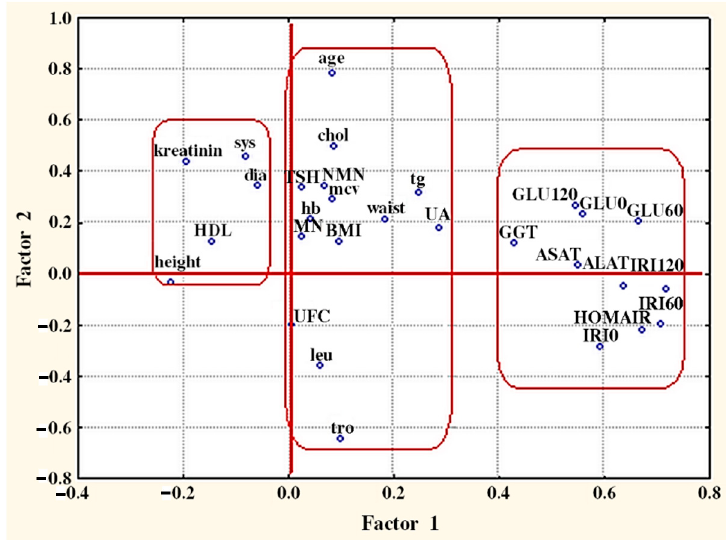
Figure 4. Plot of factor loadings (F1 vs F2). The included variables with their abbreviations are metanephrine (MN), normetanephrine (NMN), age, height, waist, body mass index (BMI), HOMA-IR, systolic blood pressure (sys), diastolic blood pressure (dia), leucocytes (leu), hemoglobin (hb), thrombocytes (tro), mean corpuscular volume (mcv), total cholesterol (chol), HDL-cholesterol (HDL), triglycerides (tg), fasting glucose (GLU0), glucose at the first hour post glucose load (GLU60), glucose at the second hour post glucose load (GLU120), creatinine (kreatinin), alanine aminotransferase (ALAT), aspartate aminotransferase (ASAT), gamma-glutamyl transferase (GGT), uric acid (UA), fasting insulin (IRI0), insulin at the first hour post glucose load (IRI60), insulin at the second hour post glucose load (IRI120), free urine cortisol (UFC), and thyroid stimulating hormone (TSH).